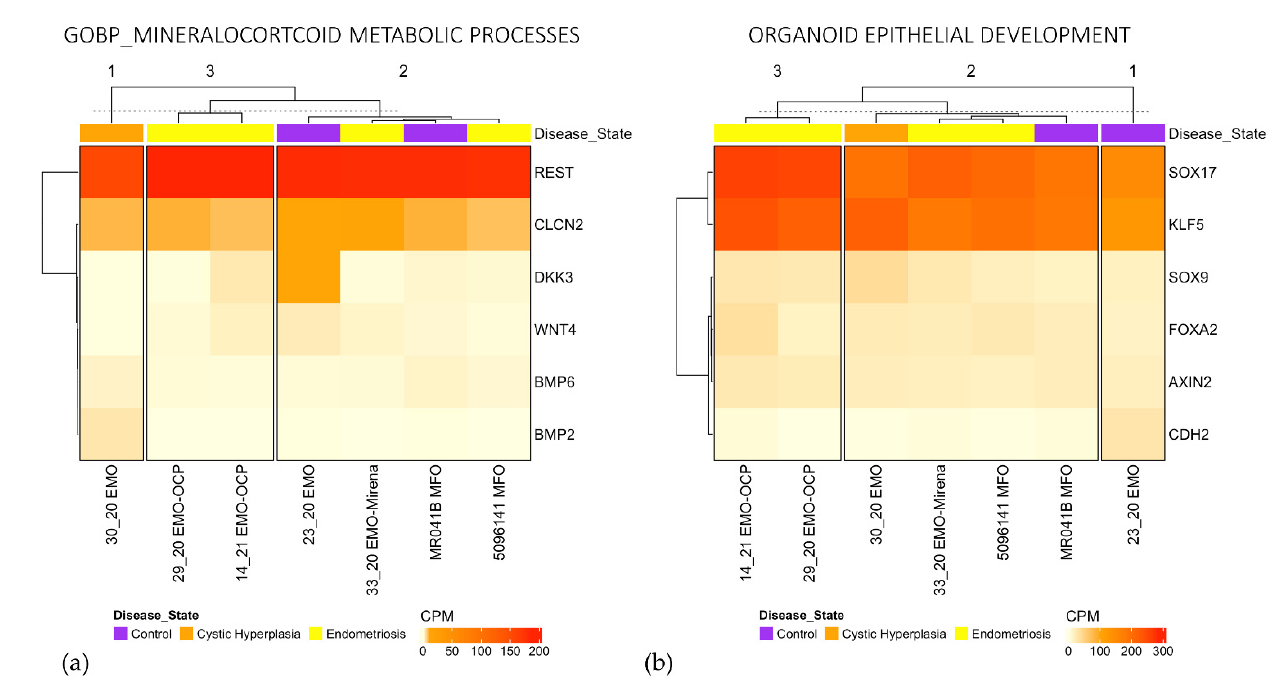
Figure 6. Gene expression heatmaps for Mineralocorticoid Metabolic Process ( a ) and Organoid Epithelial Development ( b ) show clustering of EMO-OCP but not EMO-H.